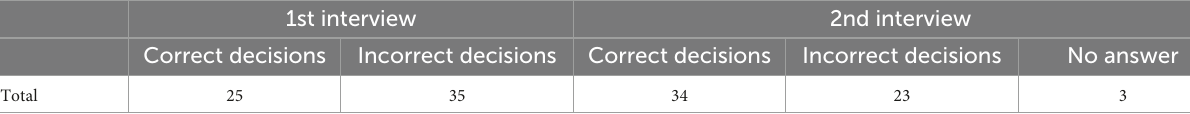
TABLE 3 Correct and incorrect decisions in 1st and 2nd